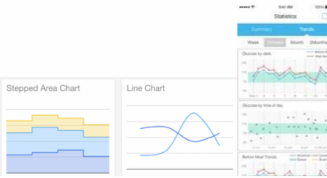
Figure 4. Charts for Google developers and iHealth Gluco-Smart.